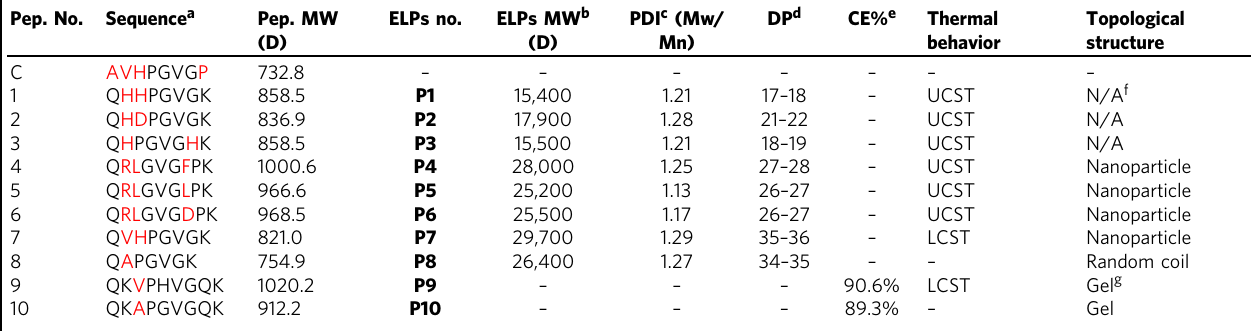
Table 1 Characterization of peptide monomers and their corresponding polymerized ELPs Pep. No. Sequence a